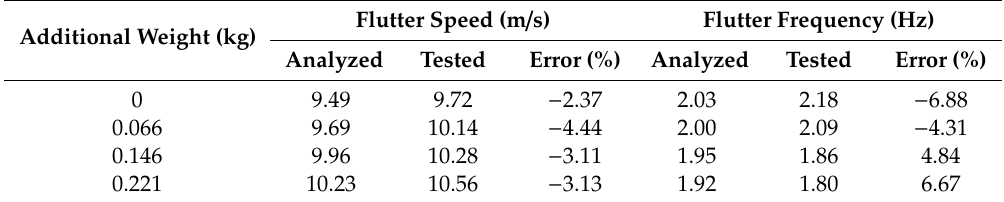
Table 6. E ff ect of additional weight at nose increasing on the BFF characteristics.